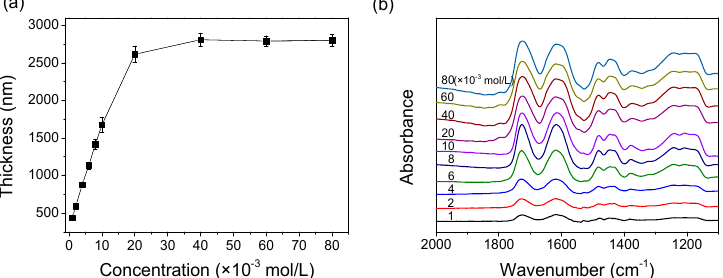
Figure 7. (PEOX/PAA) 20 prepared with different concentration: ( a ) thickness of the film as a function of the concentration; ( b ) FT-IR spectra of the films, for clearance the spectra are intentionally overlaid. ([EOX]/[AA] = 1; PEOX, M w 500,000; PAA, M w 450,000; pH 2.0; assembling time, 4 min; rinsing time, 1 min; and room temperature).